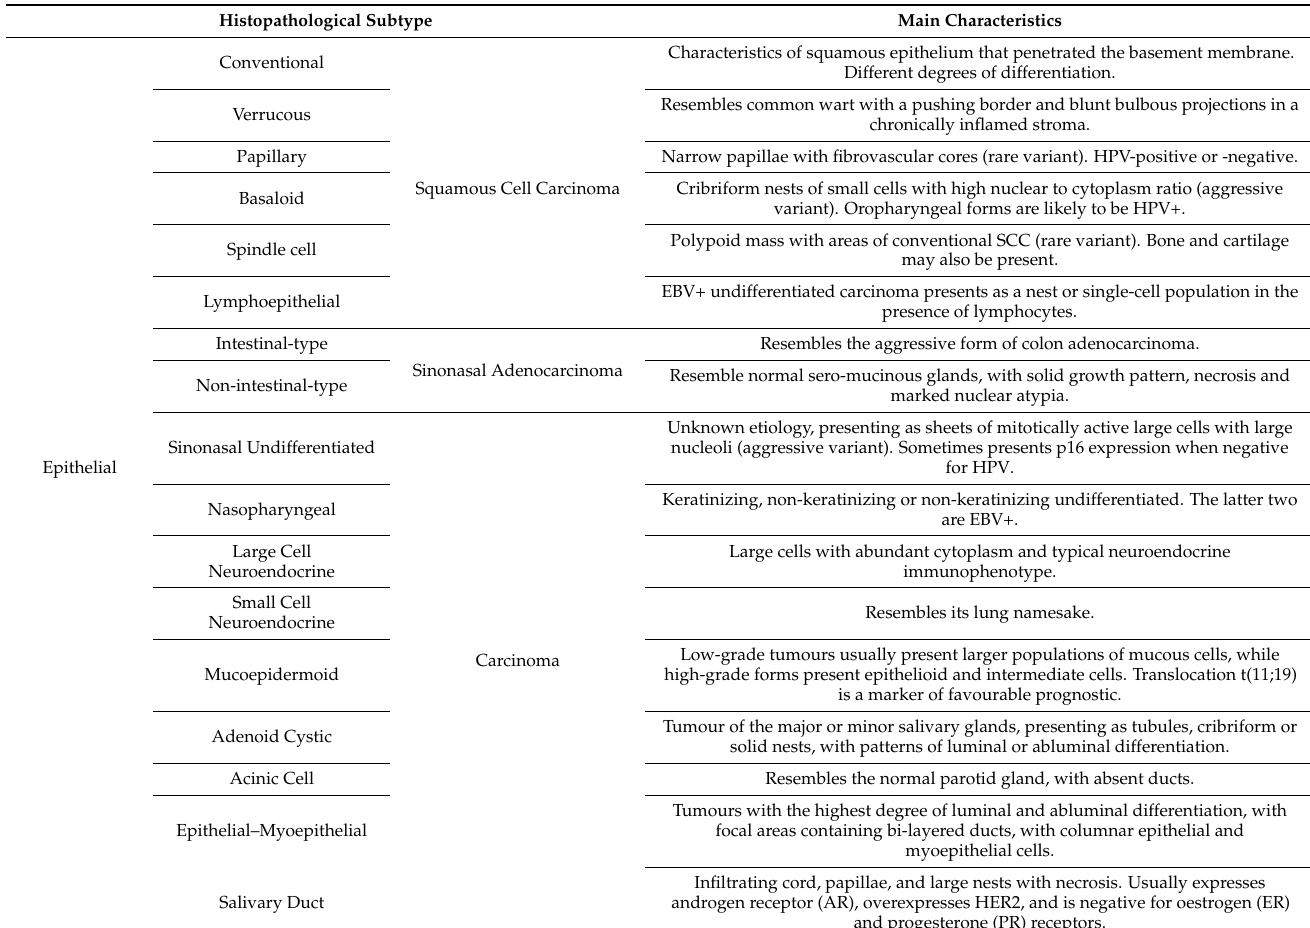
Table 3. Histopathology of HNC and their main characteristics